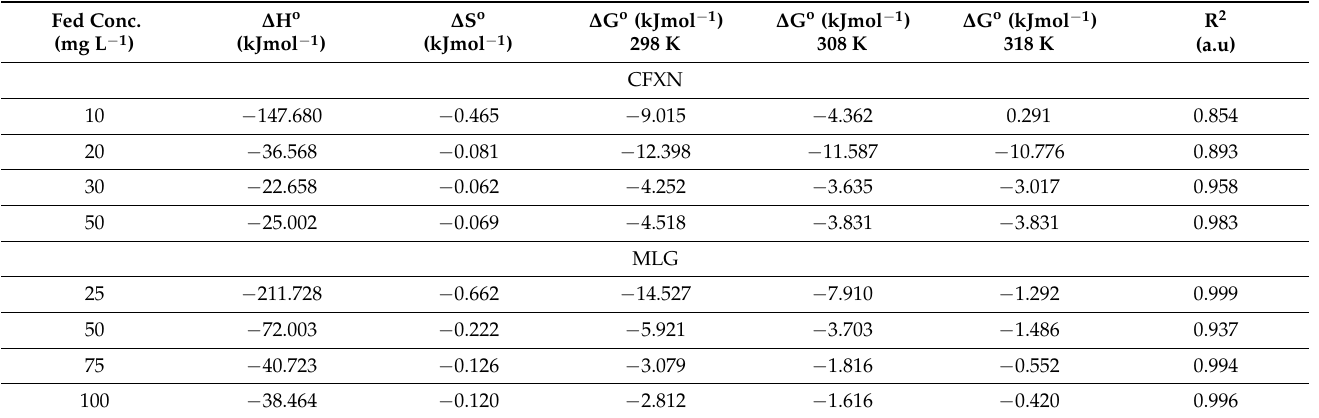
Table 2. The thermodynamic results for the adsorption of CFXN and MLG on the CNPs within a temperature range of 25 ◦ C to 45 ◦ C using 10, 20, 30 and 50 mg L − 1 CFXN solutions and 25, 50, 75, and 100 mg L − 1 MLG solutions.